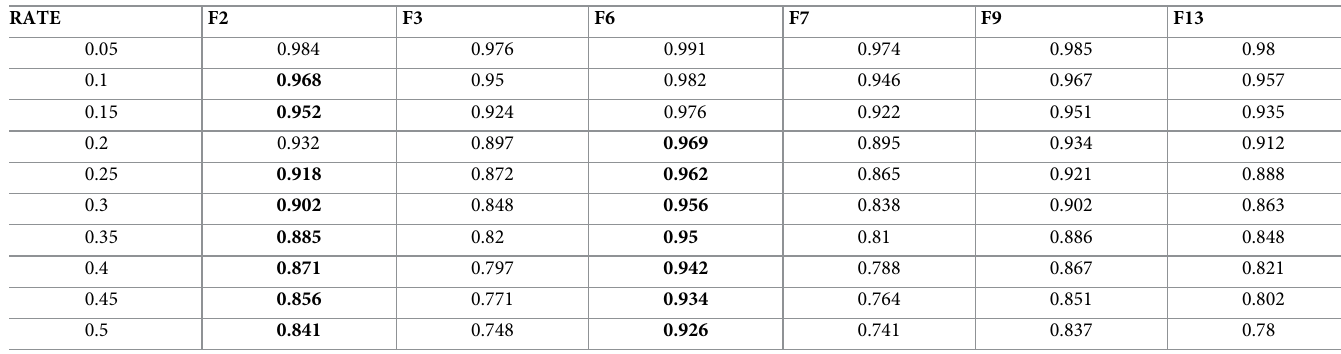
Table 14. Accuracy of mode replacement by feature.